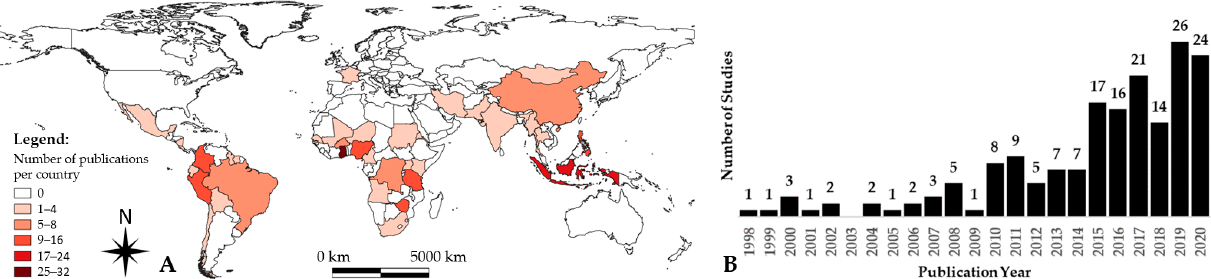
Figure 2. Geographical and temporal distribution of included articles ( n = 176) per country ( A ) and year of publication ( B ). Source: authors’ compilation from extracted data; national administrative boundaries dada ware obtained at Anomaly Hotspots of Agricultural Production (ASAP) (https://mars.jrc.ec.europa.eu/asap/files/gaul0_asap_v04.zip) [46] .